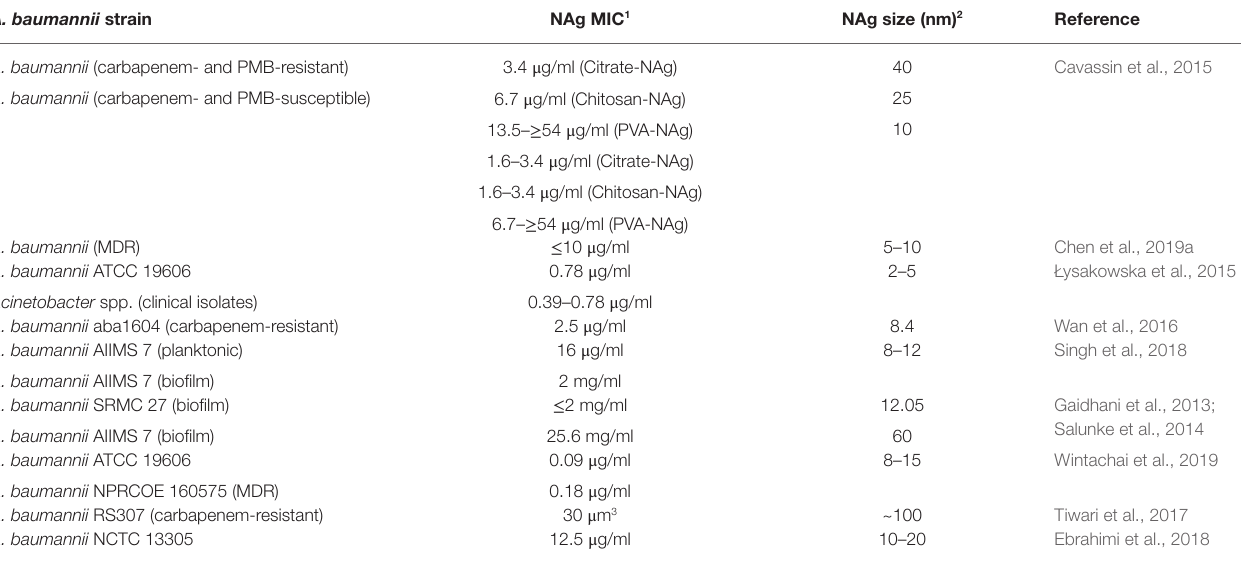
TABLE 1 | Examples of several investigations on the antibacterial activity of NAg against various multi-drug-resistant (MDR) and non-MDR Acinetobacter baumannii